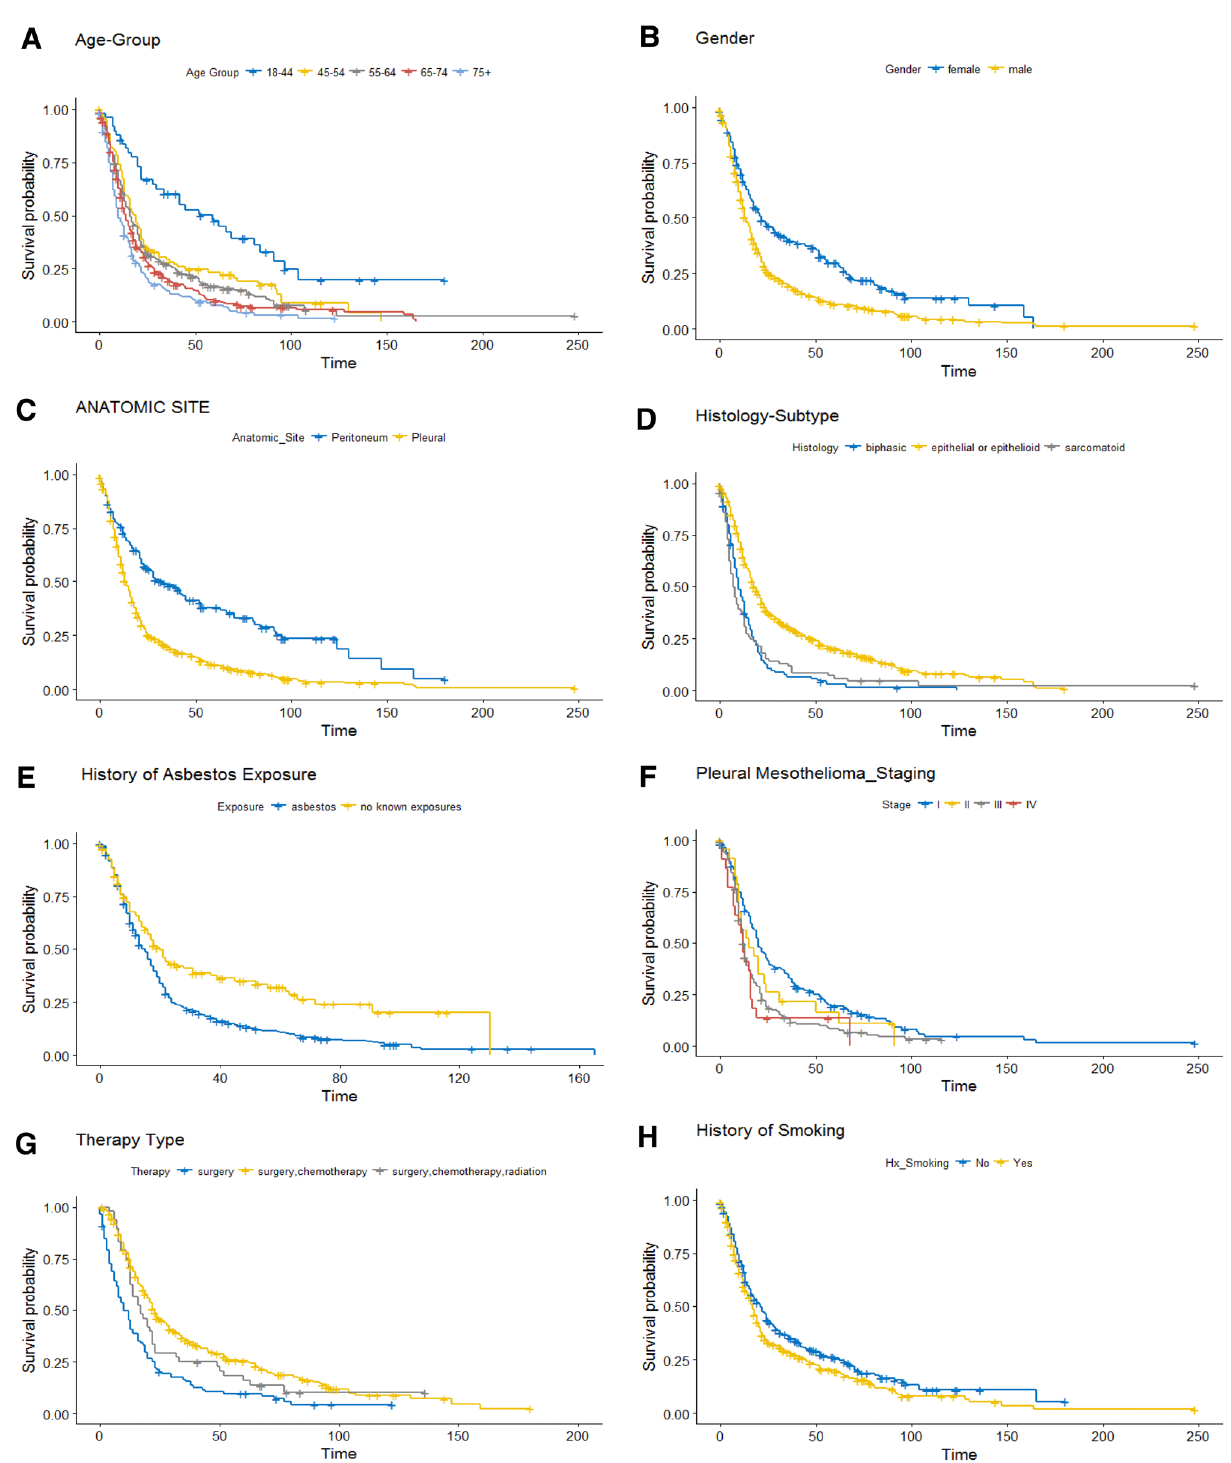
Figure 2. Kaplan Meier Curve analysis performed at age ( a ), gender ( b ), anatomic site ( c ), histology subtype ( d ), history of asbestoses exposure ( e ), staging (pleural mesothelioma) ( f ), therapy type ( g ), and history of smoking ( h